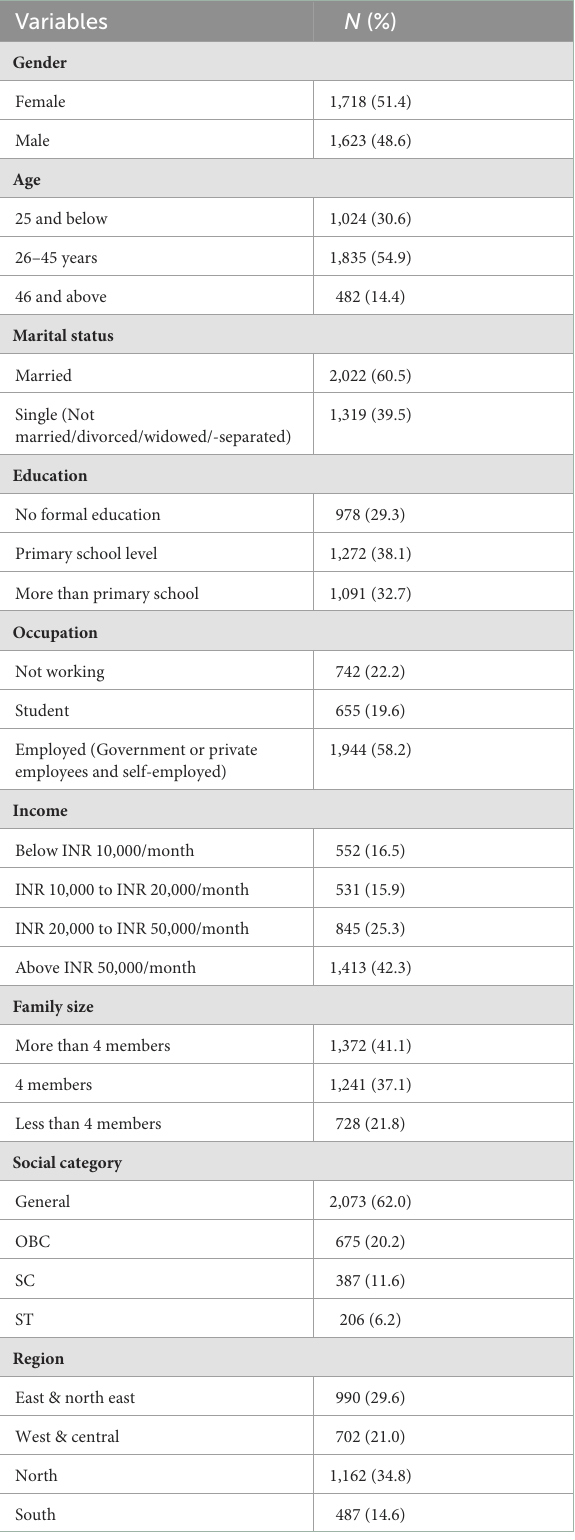
TABLE 1 Description of socio-demographic factors for willingness to